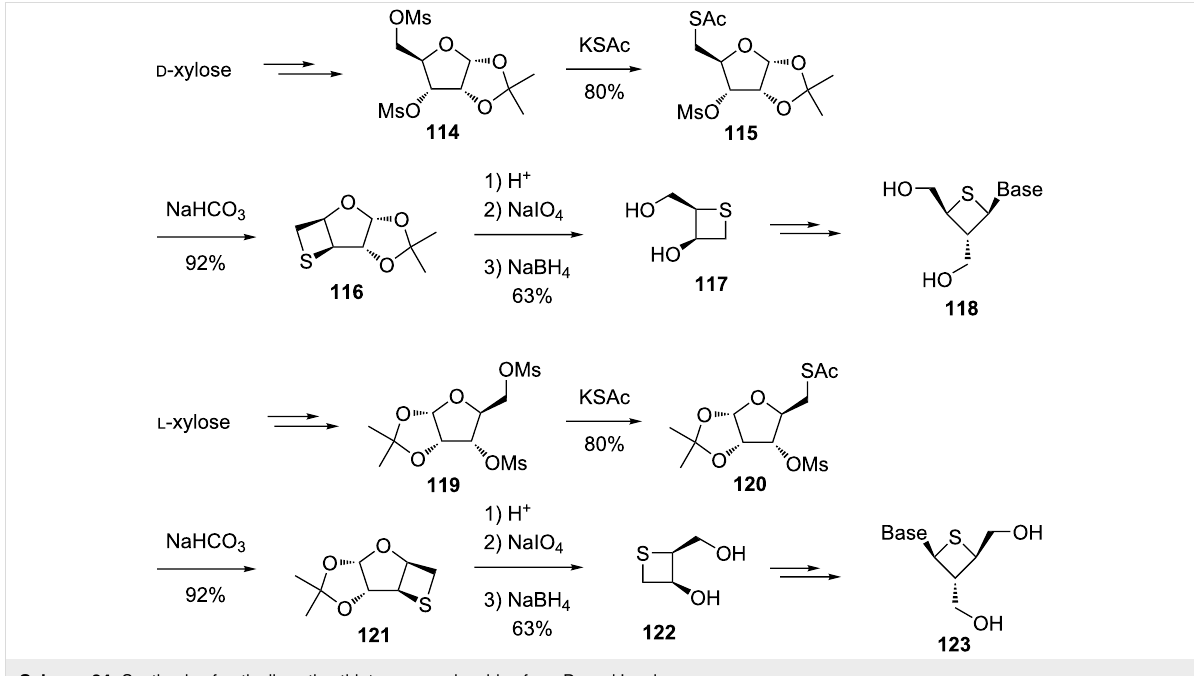
Scheme 24: Synthesis of optically active thietanose nucleosides from D- and L-xyloses.